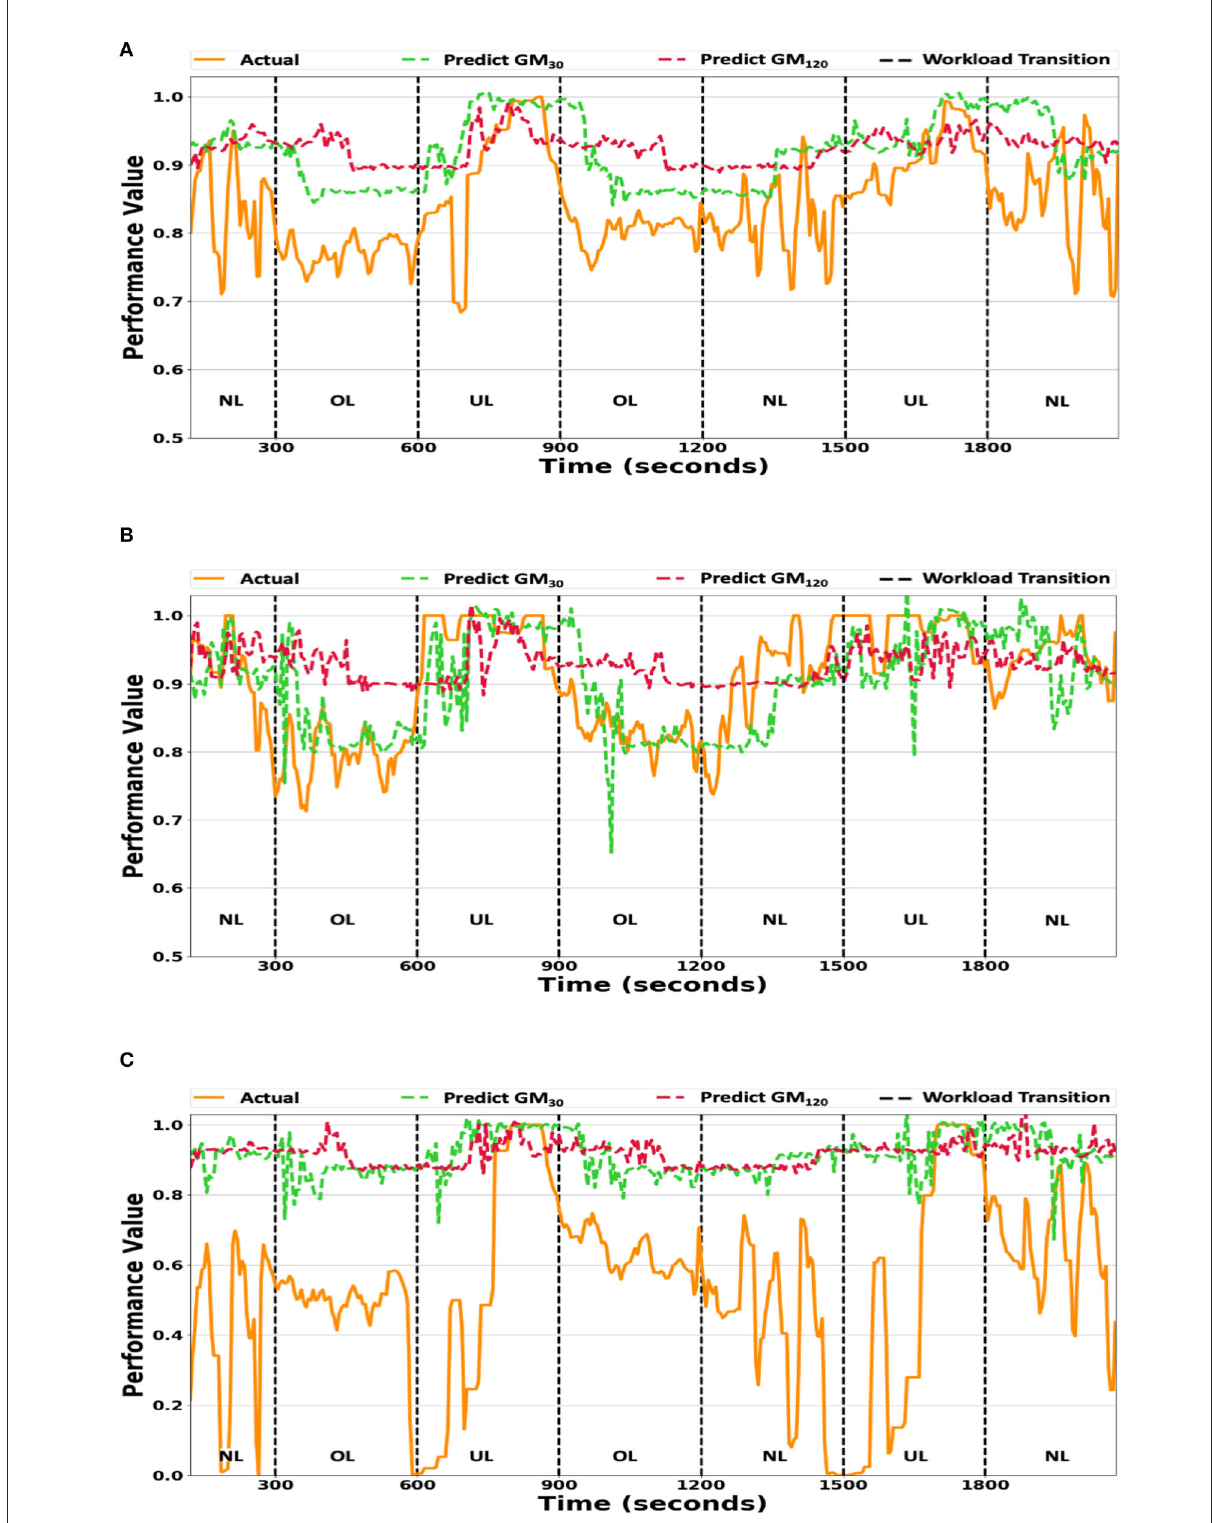
FIGURE2 (A) The generalized model’s predictions vs. the averaged actual participant performance values. (B) The generalized model predictions vs. the true performance values of participant P best . (C) The generalized model predictions vs. the true performance values of participant P worst . The GM 30 and GM 120 prediction model variant’s predicted values plotted against the true performance values for workload ordering O 2 . The y-axis scale ranges from 0.5 to 1.0 for (A,B) , while it ranges from 0.0 to 1.0 for (C) . UL/NL/OL in each plot represents the workload